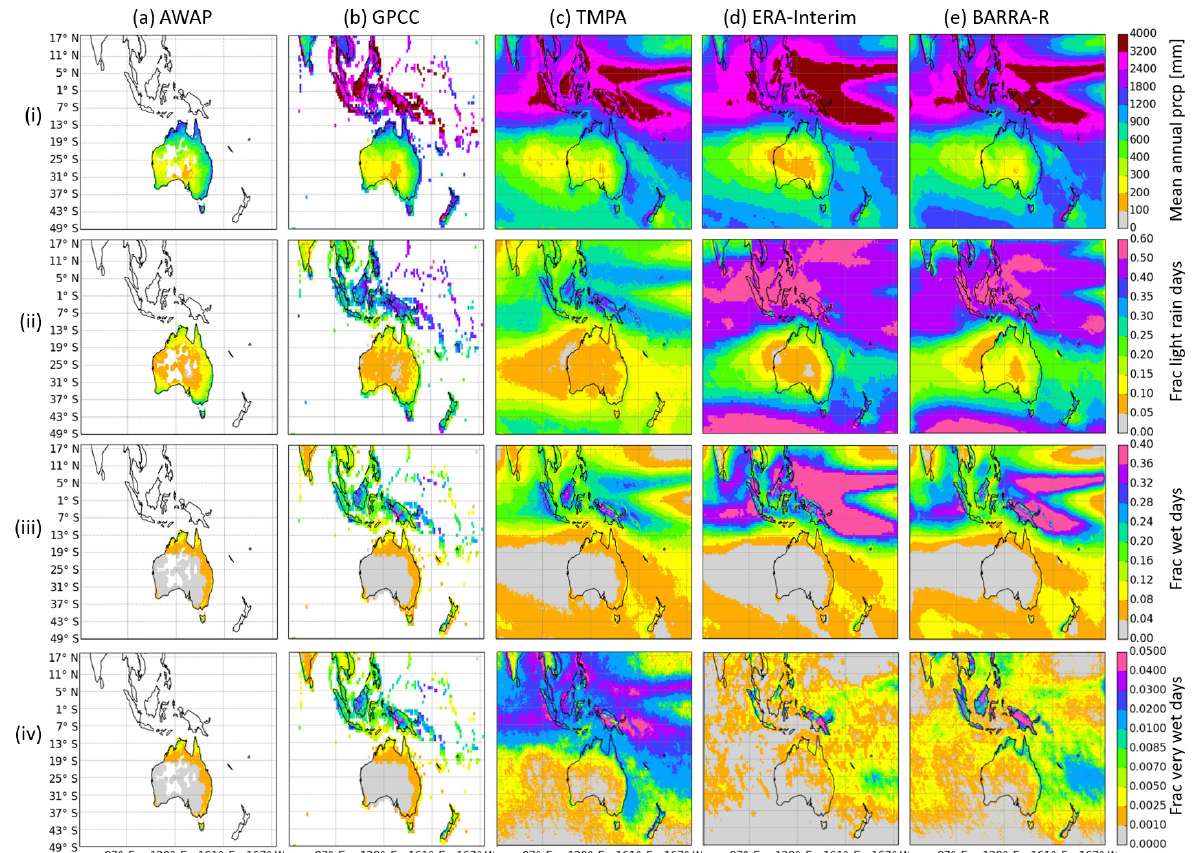
Figure 9. (i) Mean annual precipitation (mm), (ii) fractions of light rain days with 1–10mm of precipitation, (iii) heavy precipitation days with 10–50mm, and (iv) very heavy precipitation days with > 50mm over 2007–2016 from (a) AWAP, (b) GPCC, (c) TMPA, (d) ERA- Interim, and (e) BARRA-R. Regions with more than 10% missing values in AWAP are masked. Close-ups of the plots over Australia are provided in the Supplement (Fig.